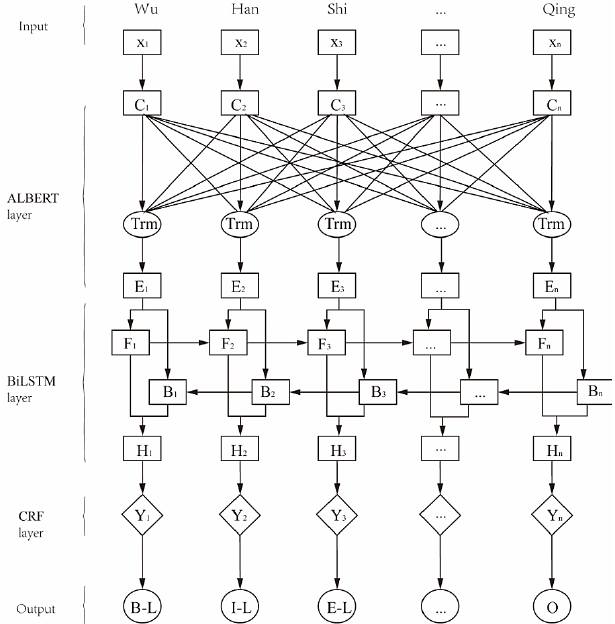
Figure 3. The overall architecture of the proposed model.